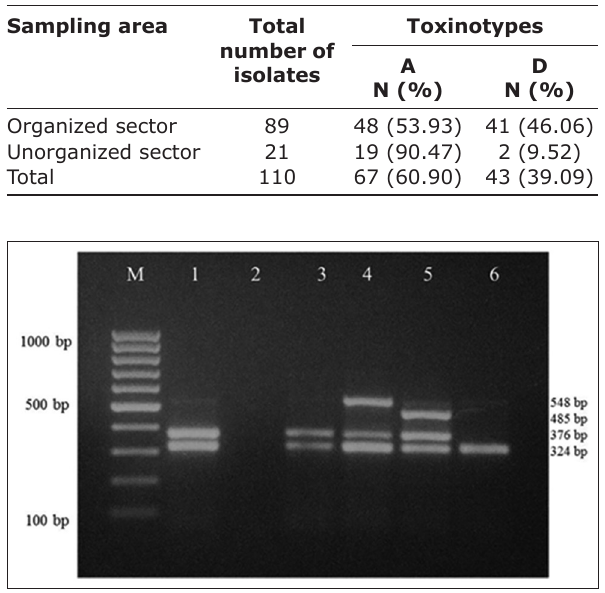
Fig ure‑3: Multiplex polymerase chain reaction amplicons of different virulence genes of Clostridium perfringens. Lane M: 100 bp DNA ladder. Lane 1: Positive control of C. perfringens Type D with amplified cpa (324 bp) and etx (376 bp) genes. Lane 2: Negative control. Lane 3: C. perfringens Type D. Lane 4: C. perfringens Type D with amplified cpa, etx and beta2 ( 548 bp) genes. Lane 5: C. perfringens Type D with amplified cpa, etx, and cpe (485 bp) genes. Lane 6: C. perfringens Type A with cpa gene